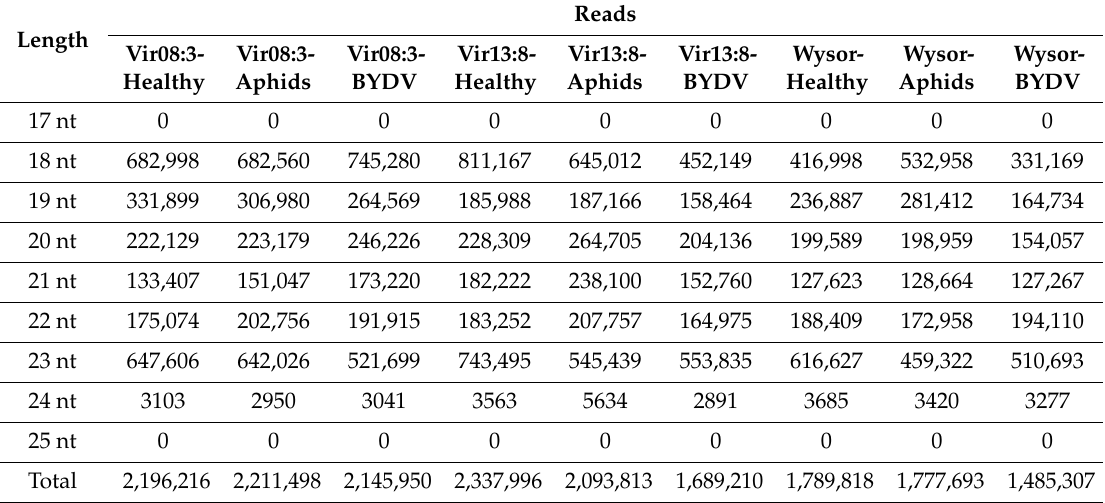
Table 1. Length distribution across individual biological triplicates. Total reads of all miRNAs were calculated.